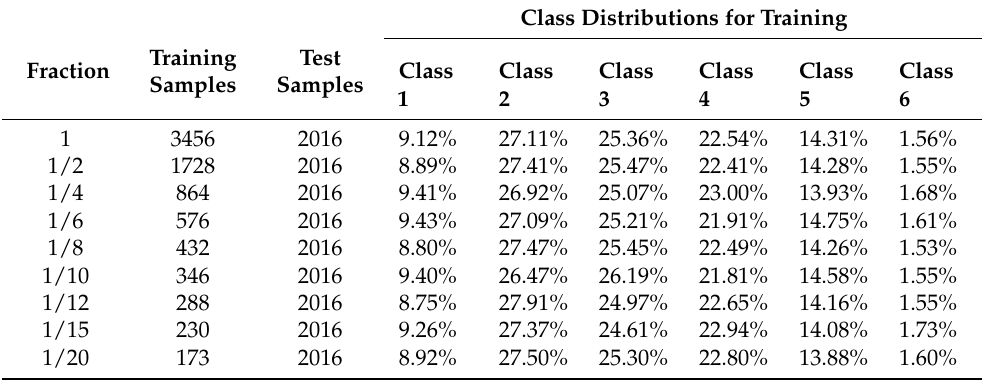
Table 10. Minimal training supervision test cases and class